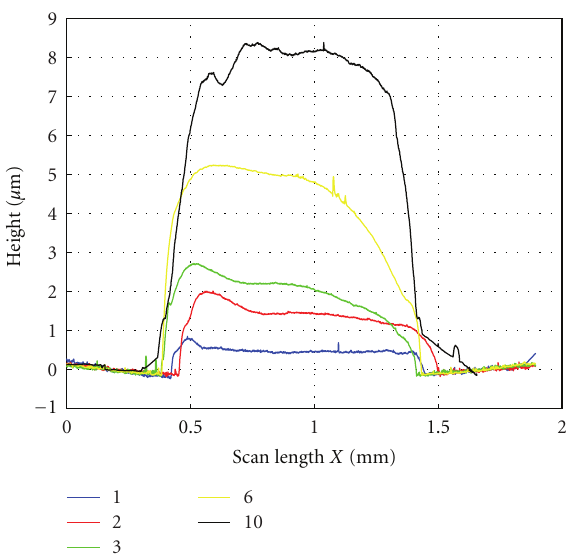
Figure 5: Obtained profiles for di ff erent number of printed layers.